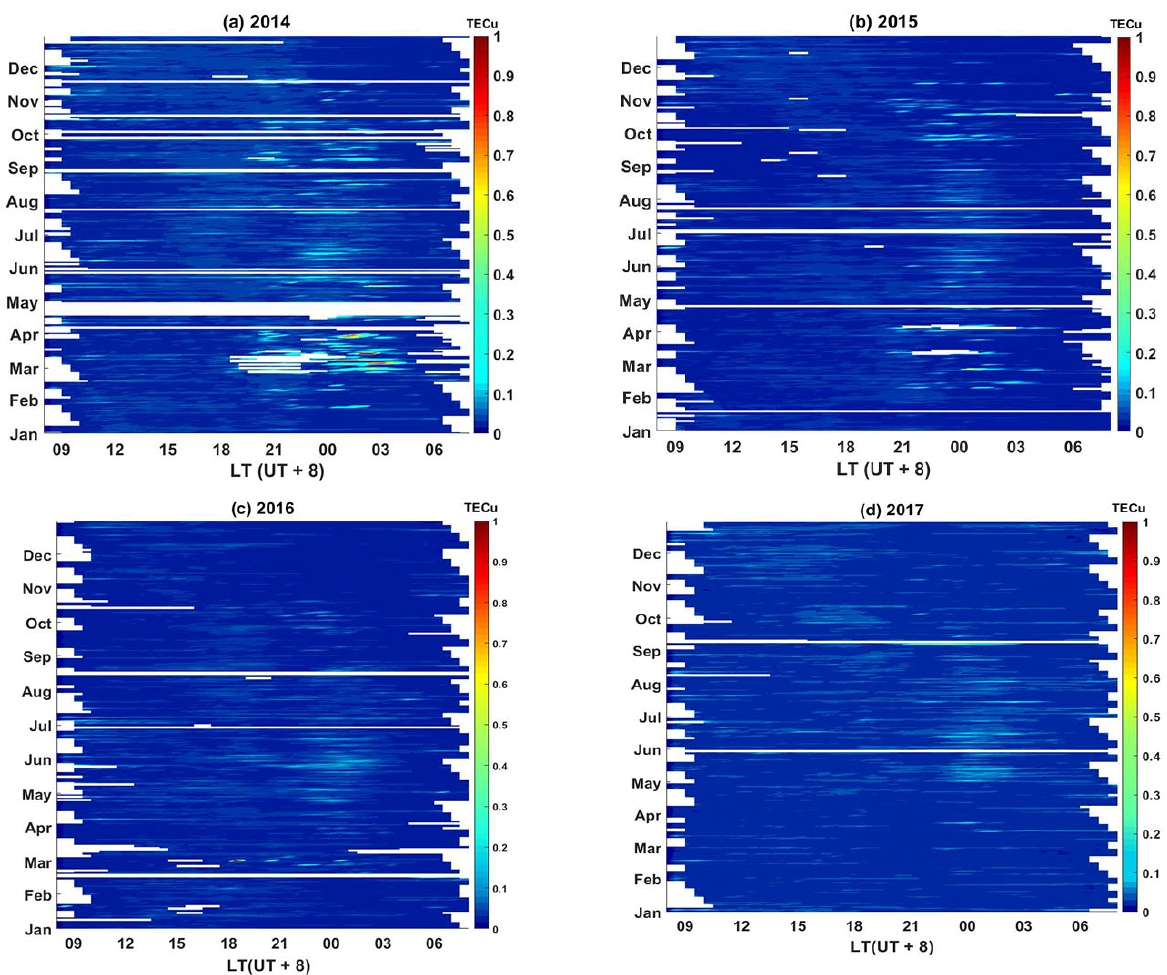
Figure 1. ROTI avg for the years 2014–2017. The abscissa axis shows the local time (LT: UT + 8) in hours. The ordinate axis shows the months of the year. The color bar shows the ROTI avg values in TECu.